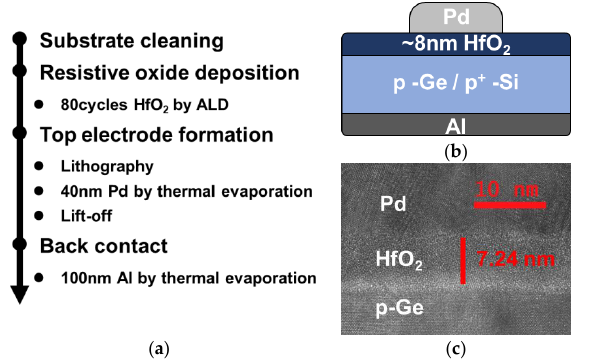
Figure 1. MIGe RRAM devices’ ( a ) process flow, ( b ) structure schematic and ( c ) TEM graph.